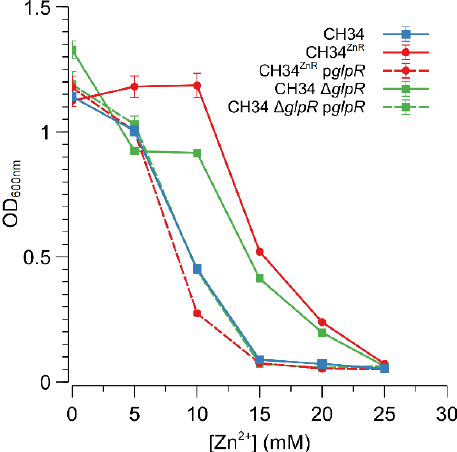
Figure 4. Impact of GlpR function on the increased zinc resistance of C. metallidurans CH34. Dose– response experiments with CH34 Δ glpR (green, squares) and CH34 ZnR (red, circles) without (full lines) or with (dashed lines) plasmid-based glpR complementation. The dose–response experiment with the parental CH34 strain is shown as a blue line (squares). The average values of three independent experiments with standard deviations are shown.